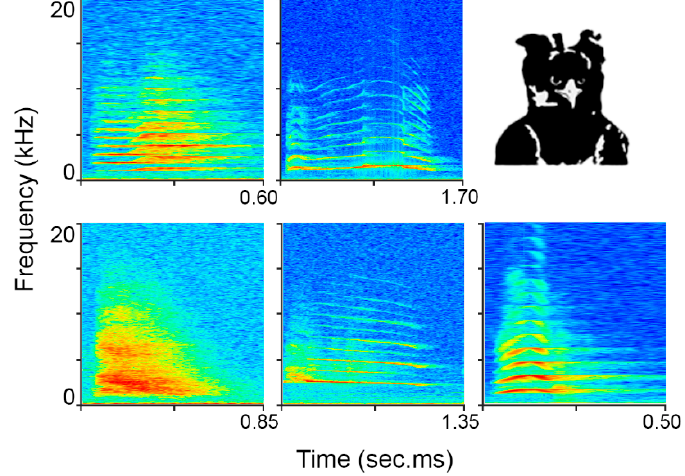
Figure 4. The five different vocal types of the harpy eagles that were used.